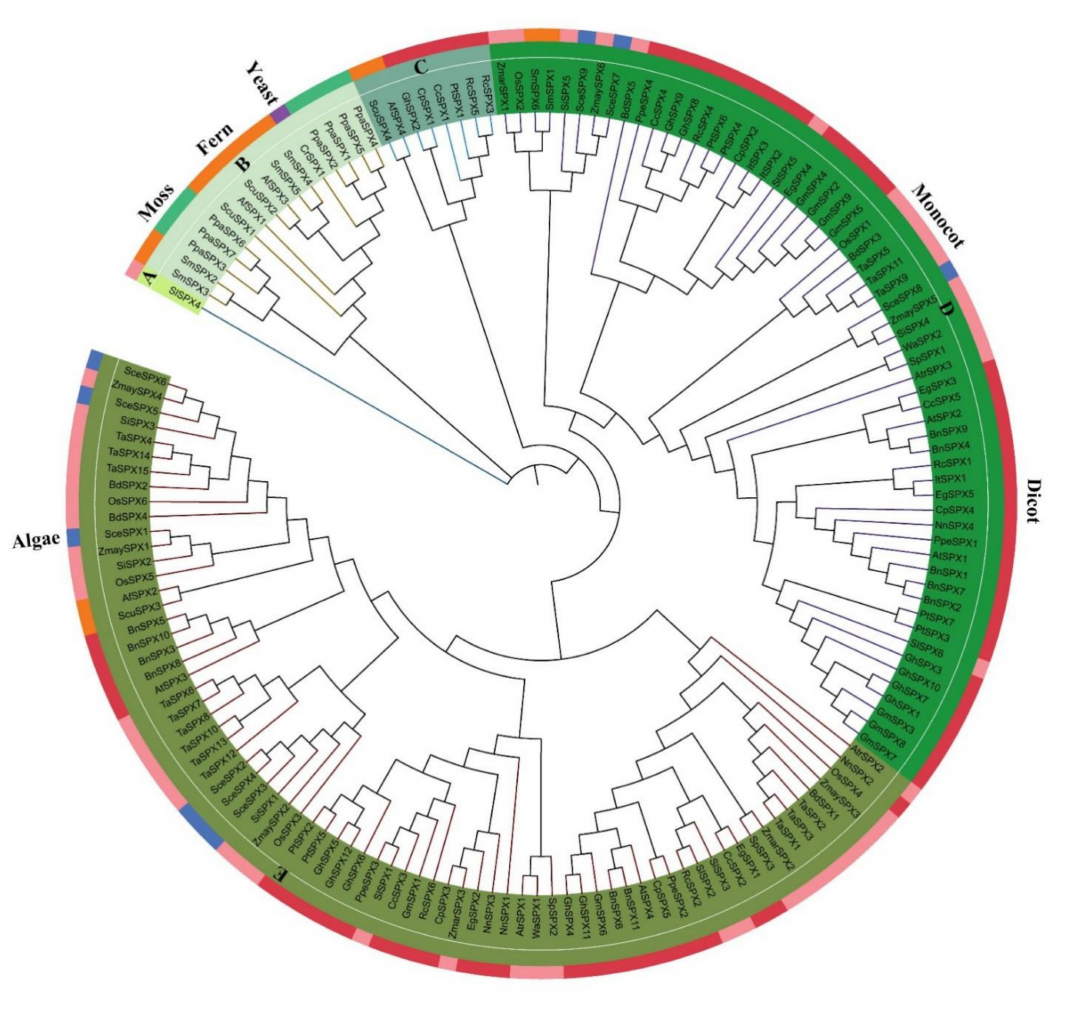
Figure 1. Phylogenetic analysis of 160 SPX genes in 28 species, including yeast, algae, moss, fern, monocot, and dicot plants. Maximum likelihood tree was generated by MEGA 7.0 with 1000 bootstrap replications on the basis of LG model. The 160 SPX genes were divided into five groups and labeled by different